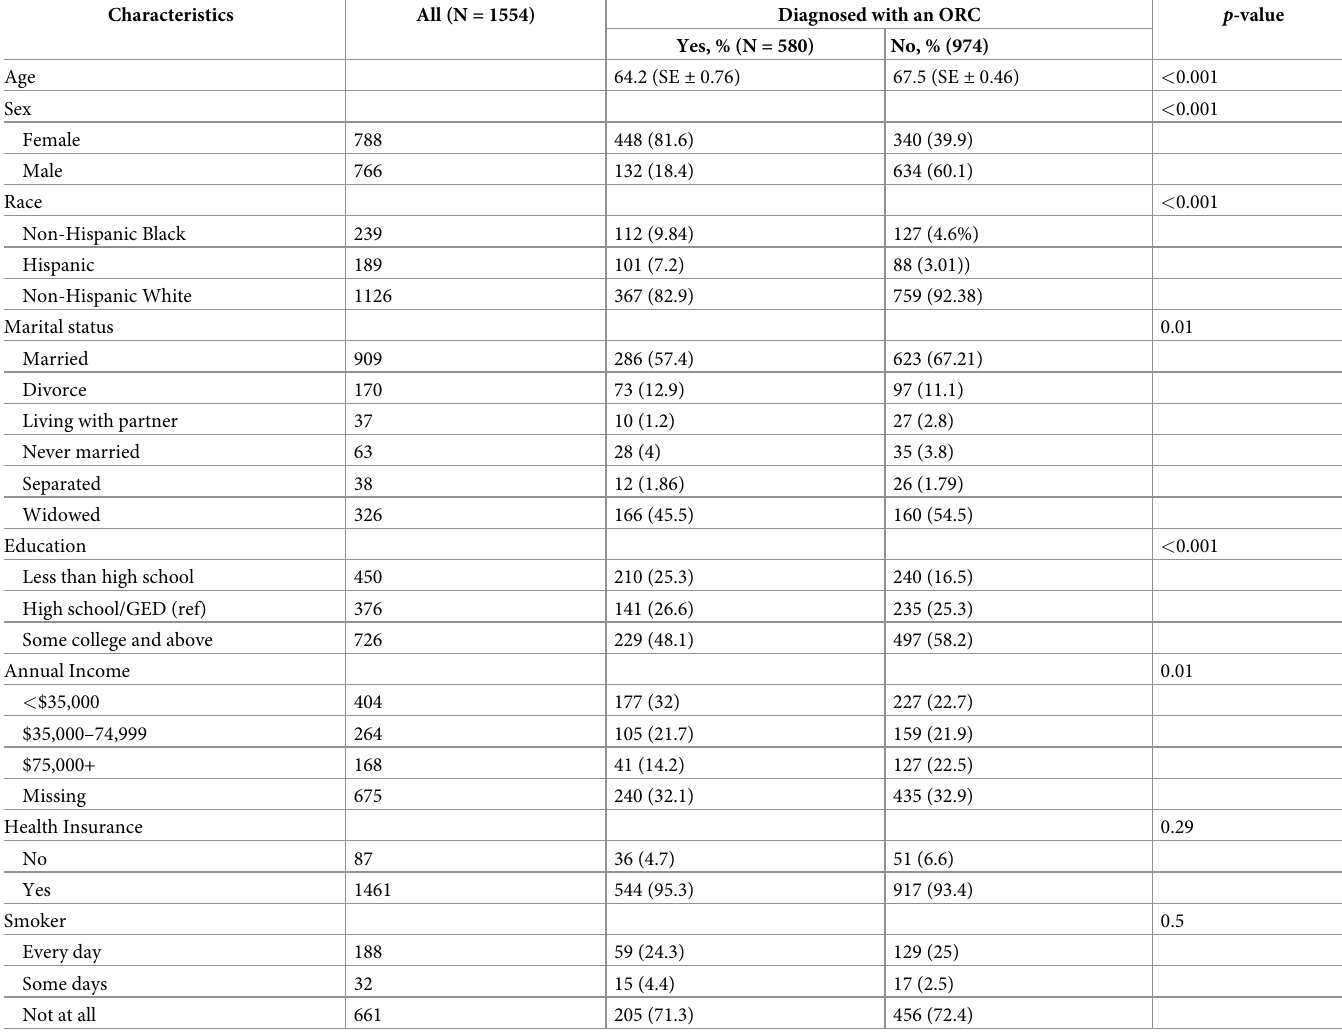
Table 1. Baseline characteristics of comorbid metabolic syndrome and cancer, NHANES 1999–2014.